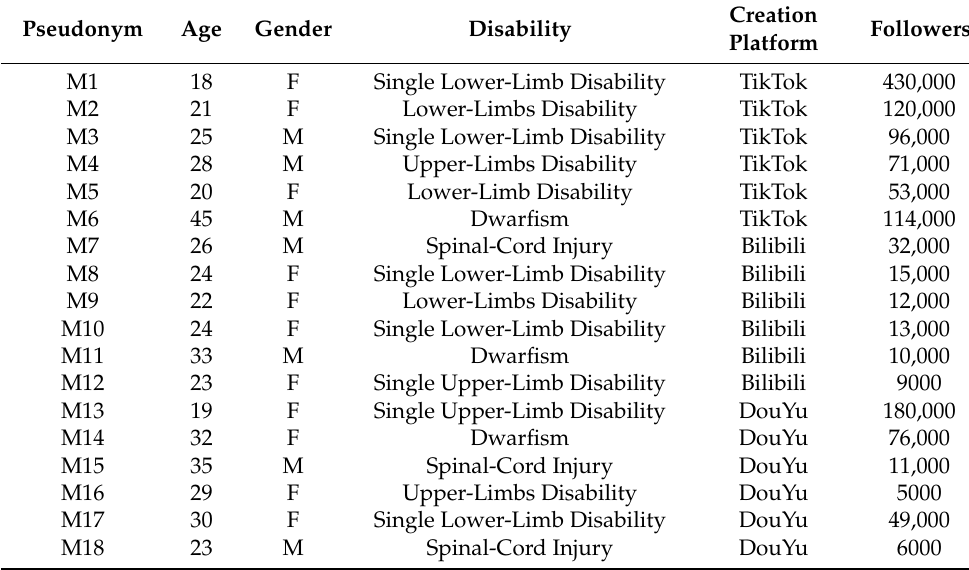
Table 1. Sociodemographic characteristics of the